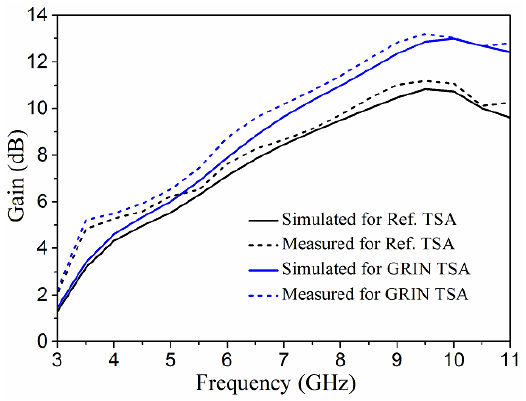
Figure 12: Measured gain of the reference TSA and GRIN TSA at the direction of x axis.